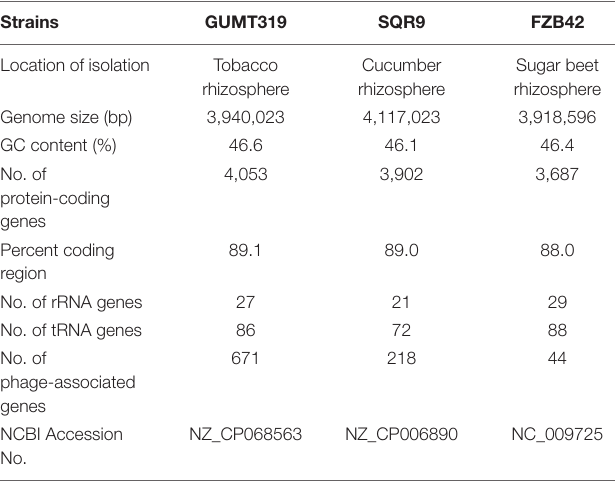
TABLE 1 | Genomic features of Bacillus velezensis strains GUMT319, SQR9, and FZB42. Strains